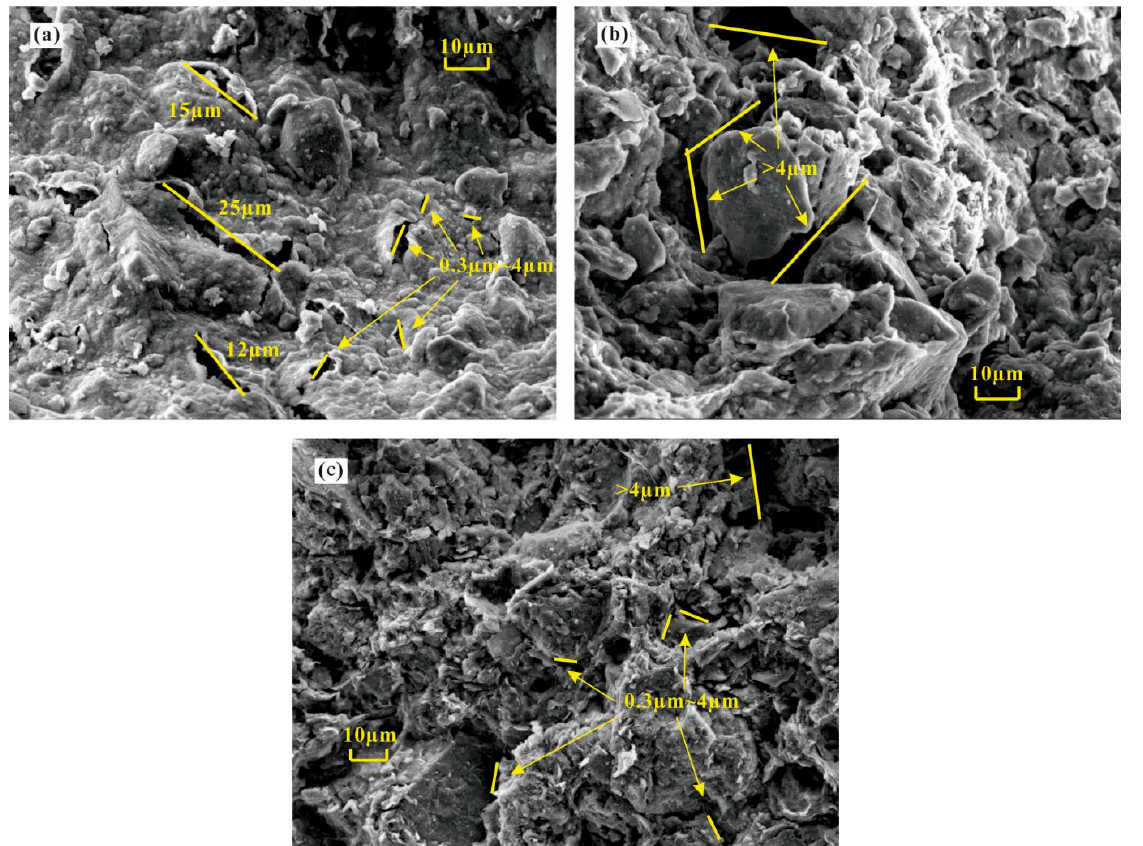
Figure 8. SEM images of expansive soil samples under different dehydration conditions. ( a ) Micro- structure of expansive soil in its initial state; ( b ) Microstructure of expansive soil after dehydrated and stabilized at 50 °C-10%; ( c ) Microstructure of expansive soil after dehydrated and stabilized at 50 °C-70%.